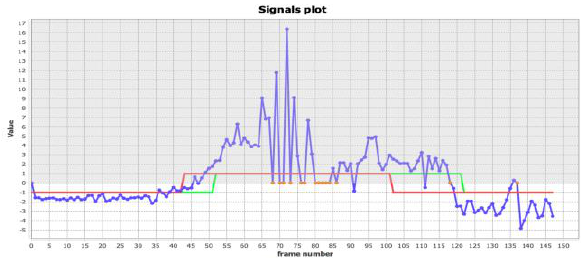
Figure 8. Example of fall detection in record ID=11\Fall\side\3, red – expert labeling (+1 – FALL, -1 – ADL), blue – SVM output as distance to optimal separating hyperplane (FALL is positive), green – cumulative sums procedure output, orange – frames with outliers.